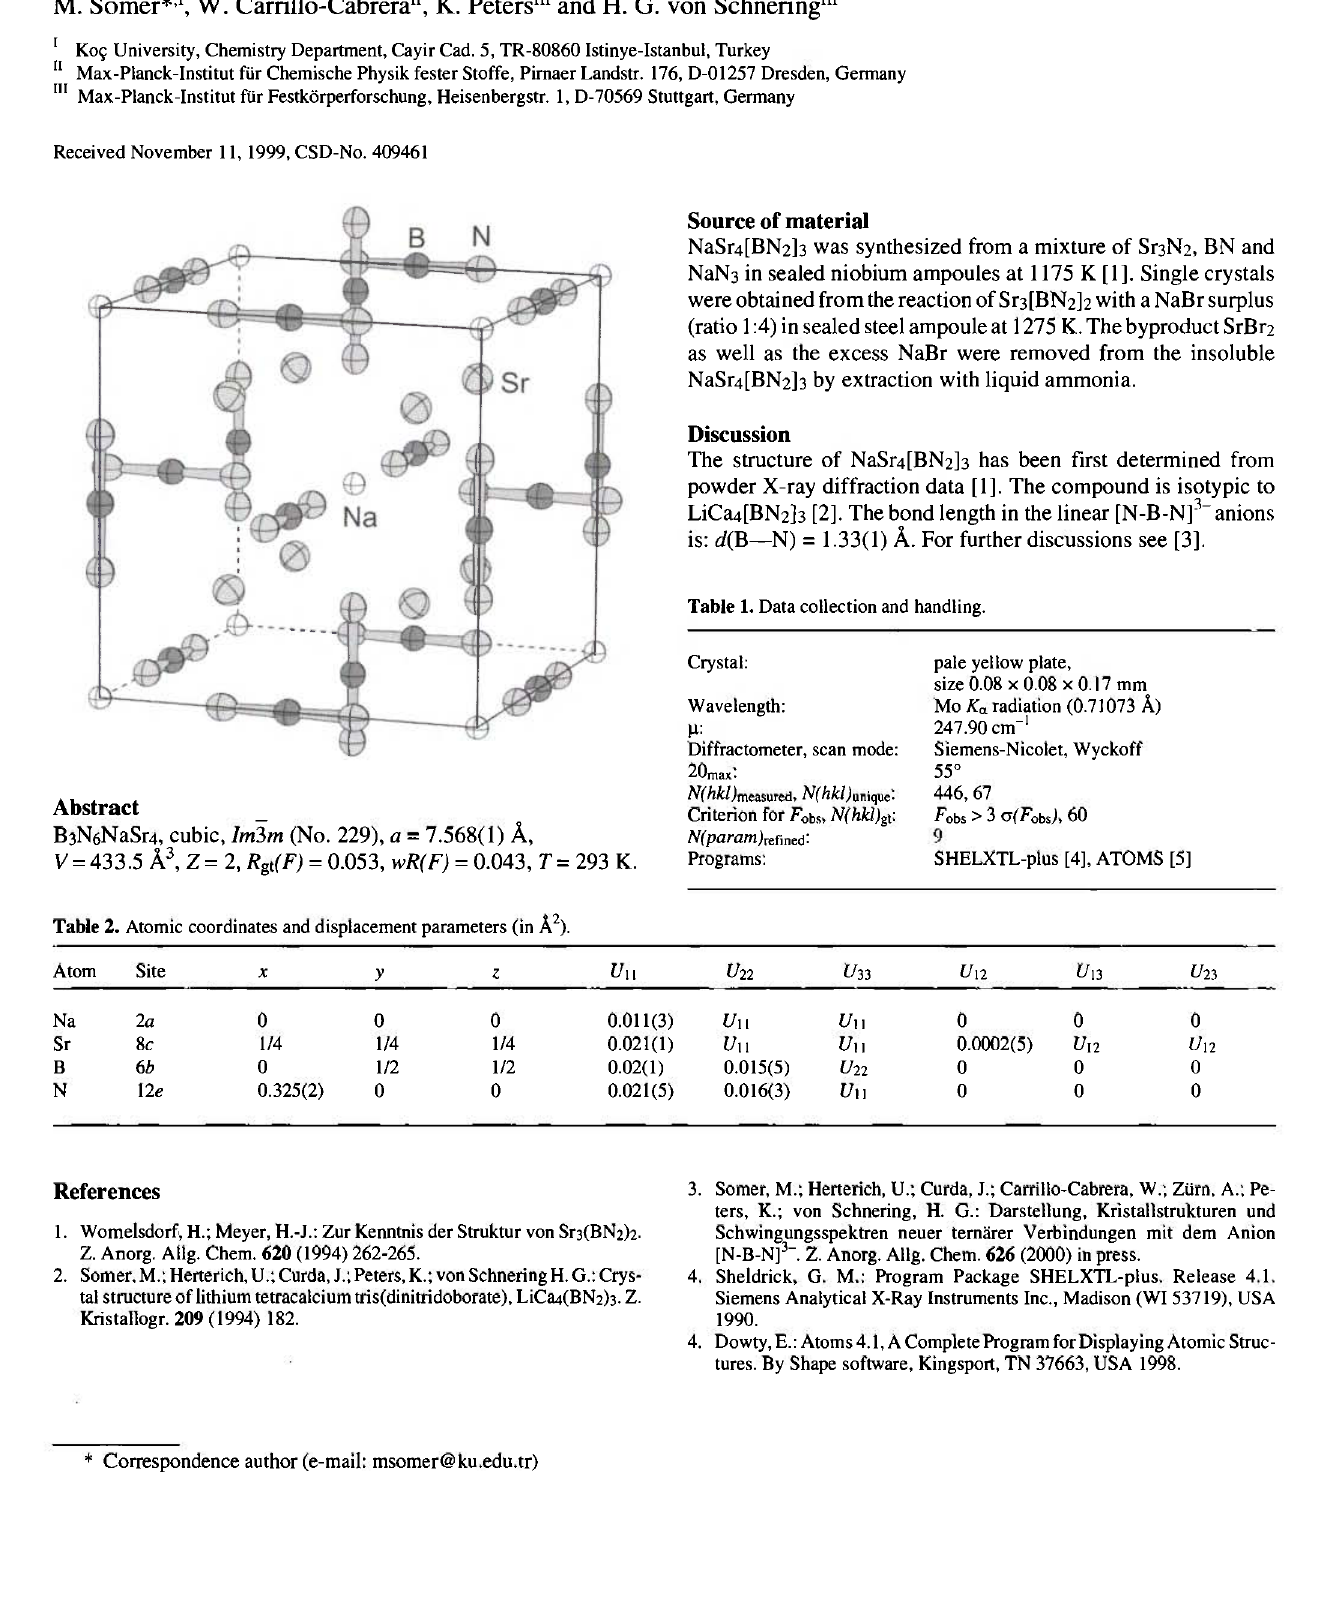
Table 2. Atomic coordinates and displacement parameters (in Ä 2 ).